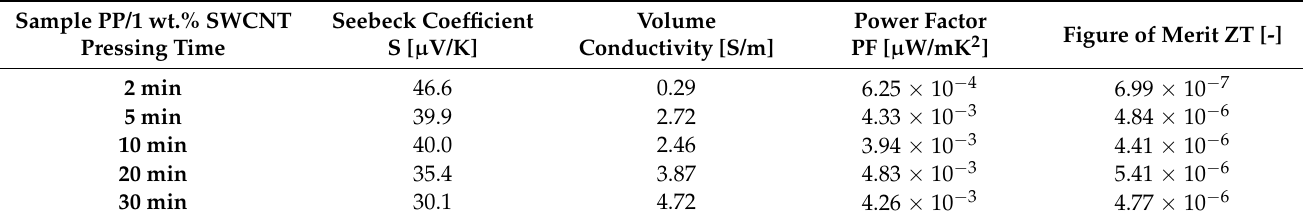
Table 5. Thermoelectric parameters of the composites at 40 ◦ C compression molded using different pressing times shown in Figure